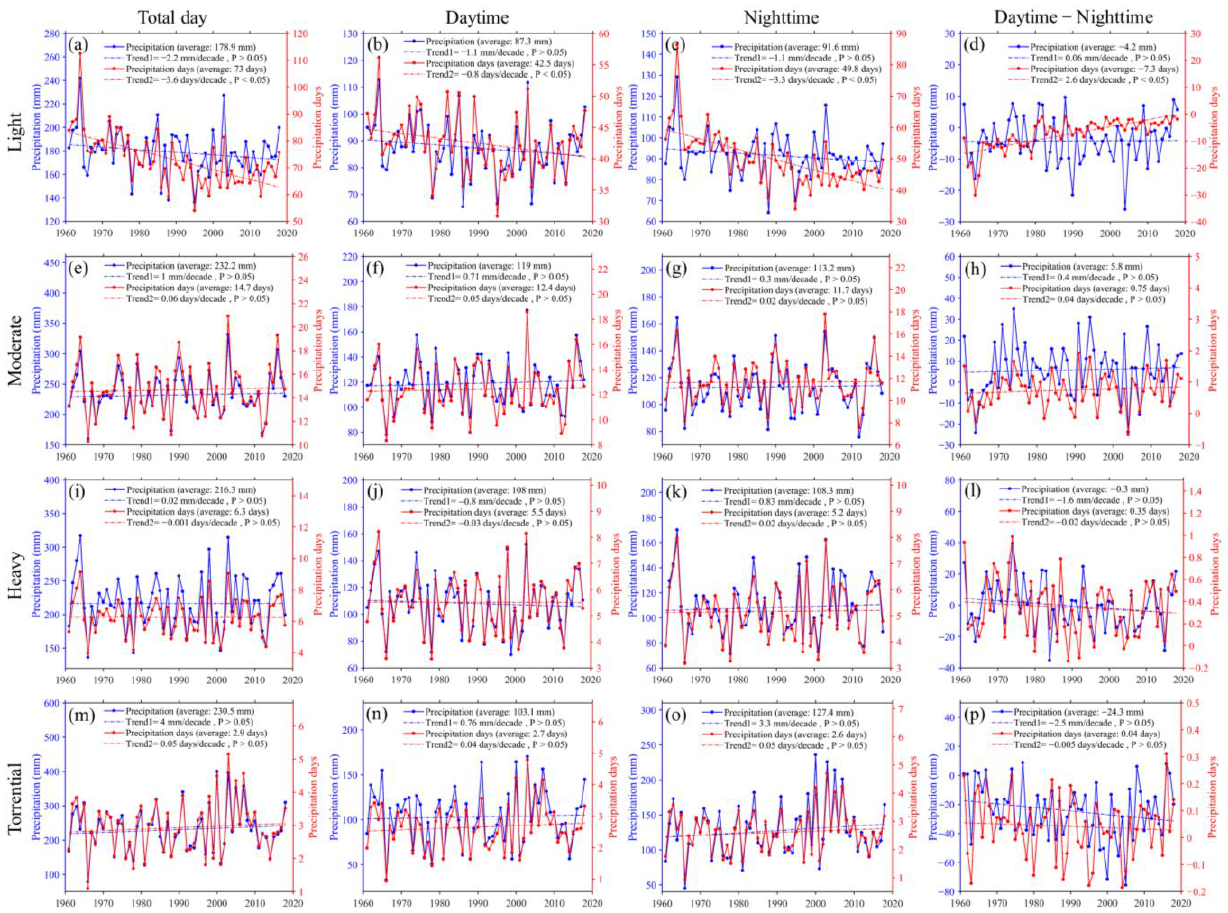
Figure 7. Time series (1961−2018) of the total, daytime, nighttime, and their difference (daytime minus nighttime) in terms of precipitation amount and days at different grades of intensity. The rows represent changes at different grades of precipitation intensity (light, moderate, heavy, and torrential), and the columns represent changes at different timescales (total, daytime, nighttime, and daytime minus